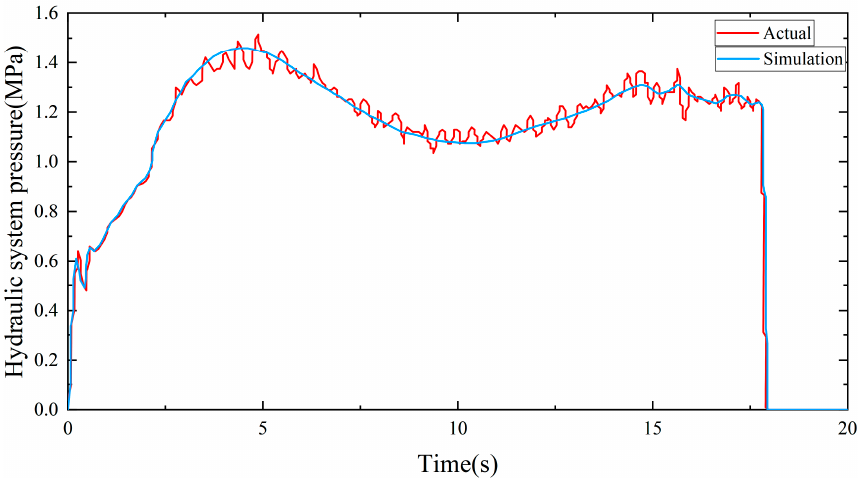
Figure 11. Comparison of pressure.